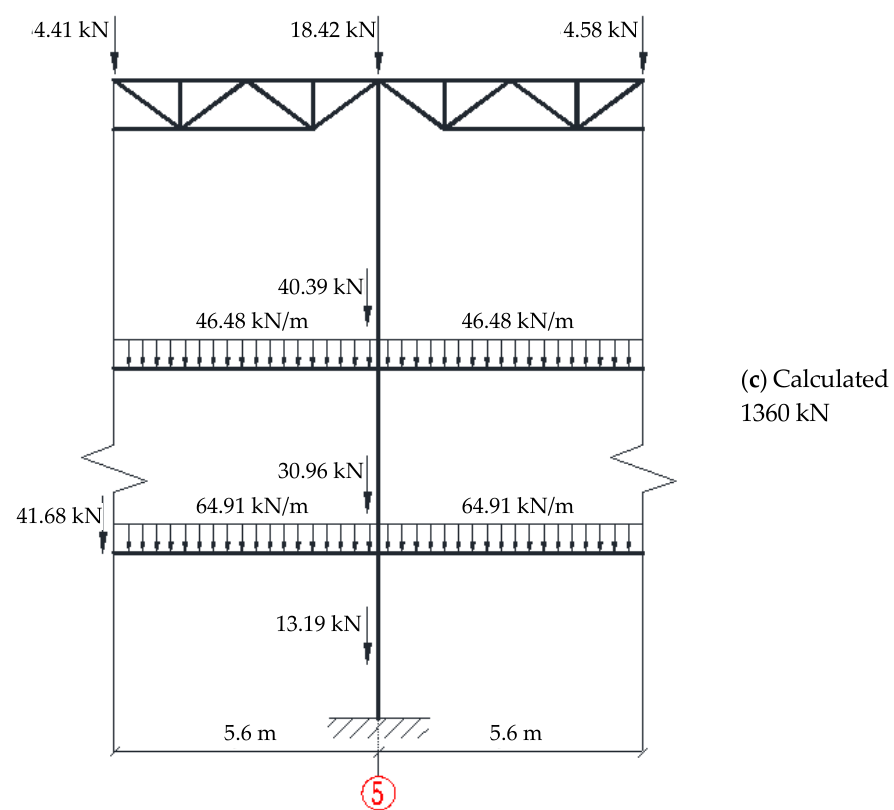
Figure 7. Calculated loads on one column in the maximum load area: ( a ) alternative 1 — building frame made of reinforced concrete prefabricated elements with metal bearing elements); ( b ) alternative 2 — prefabricated reinforced concrete frame); ( c ) alternative 3 — building frame made of monolithic reinforced concrete).